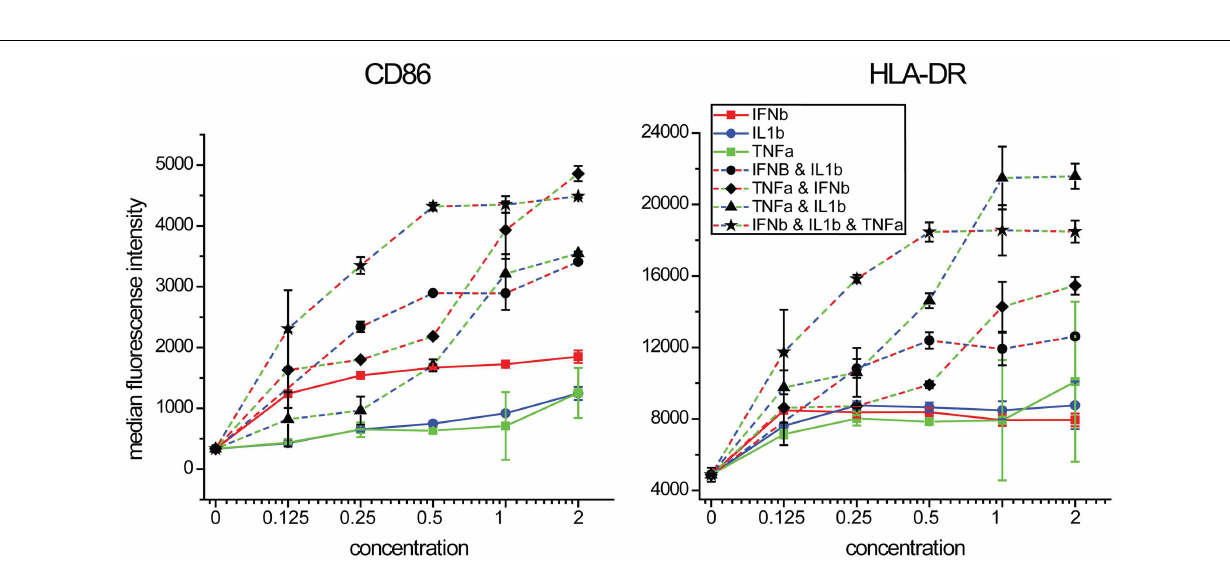
FIGURE 8 | Maturation marker expression by combinations of IFN β ,TNF α , and IL1 β . DCs were exposed to combinations of three cytokines at a range of concentrations relative to that found in supernatants of NDV infected DCs.